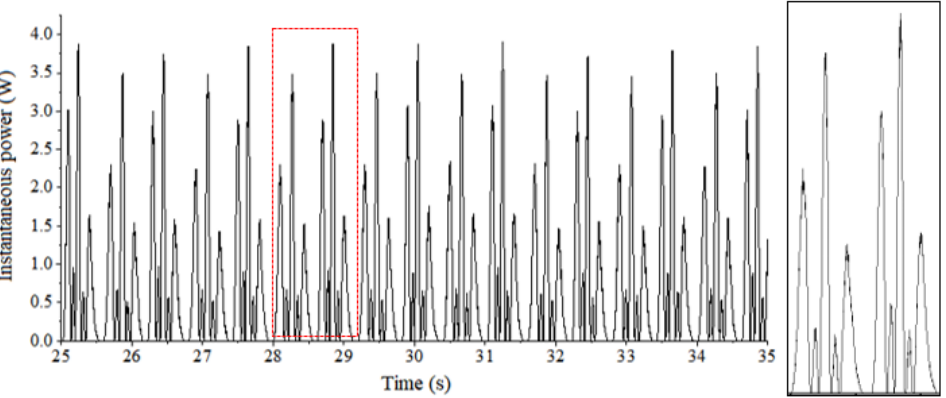
Figure 22. Active power diagram (including the zoom-up of the enclosed region between 28.0 s and 29.1 s) under fully standing waves of T / T p = 1.0, h = 0.6 m.